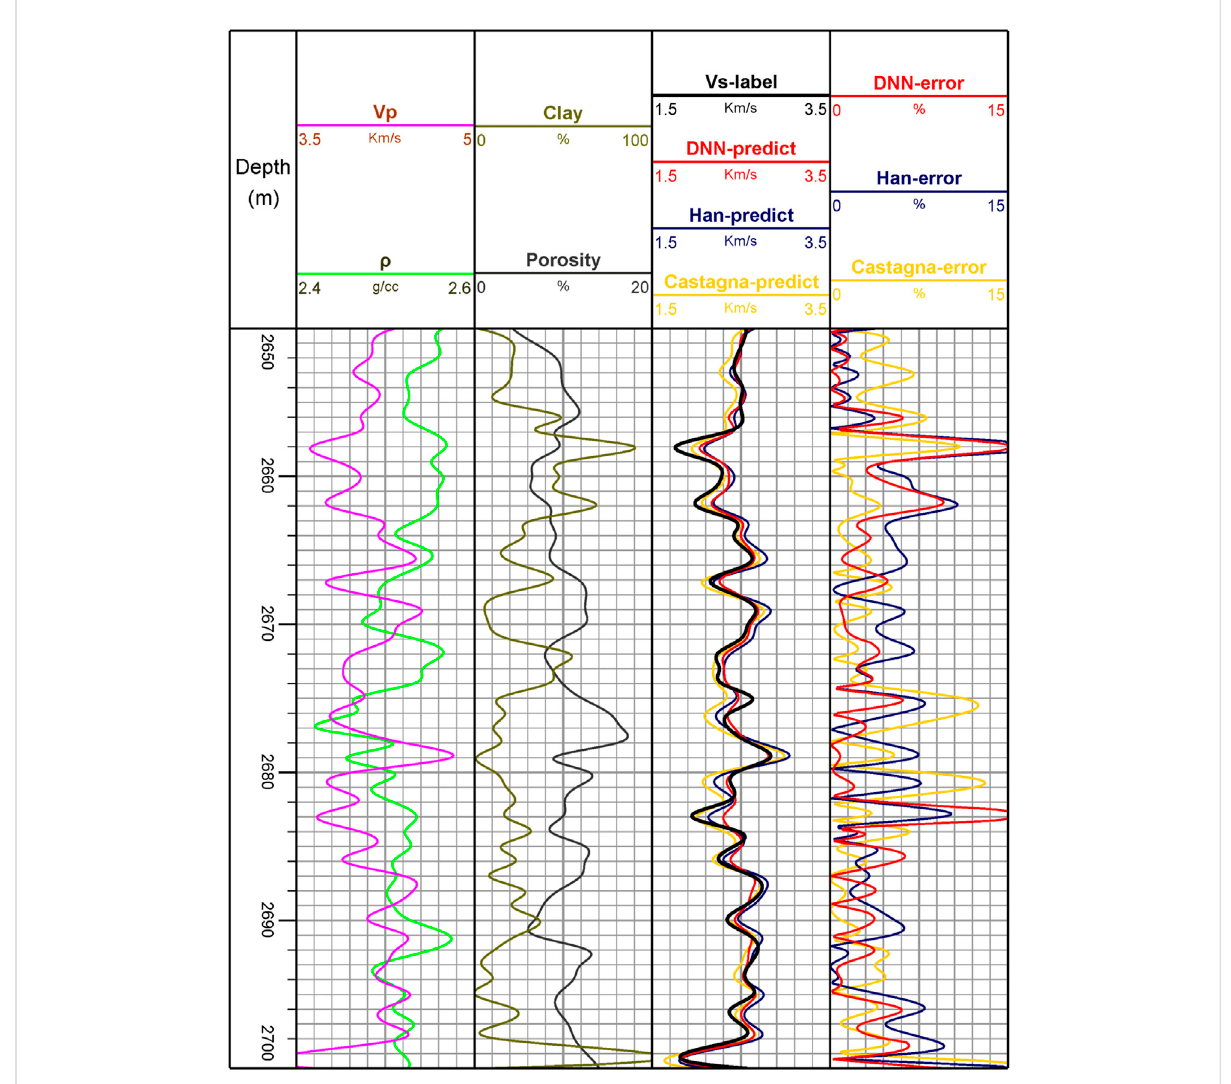
Frontiers in Earth